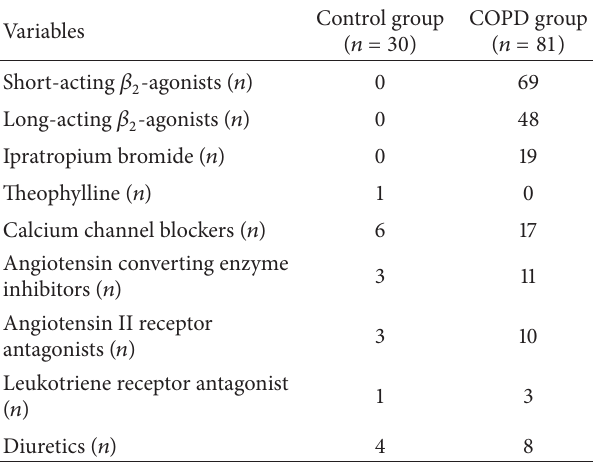
Table 2: Medication that could influence heart rate and arterial